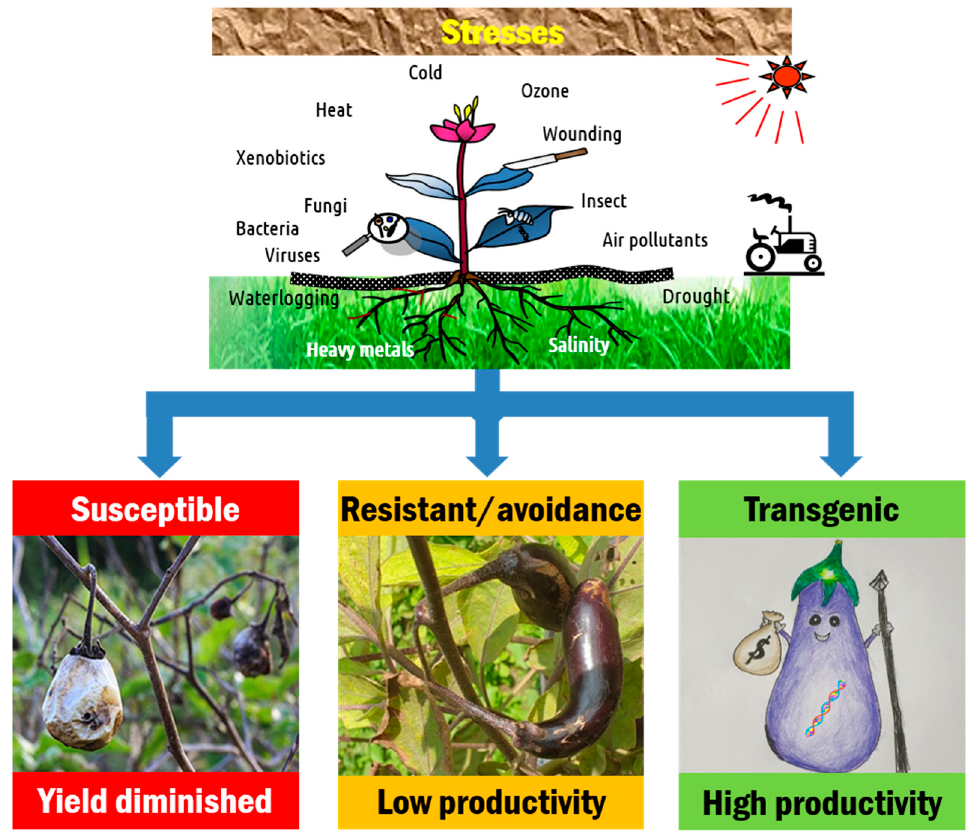
Figure 1. Stress, response, and production potential of crops. Most high-yielding cultivars are poorly adapted to environmental extremes, while landraces are able to tolerate or avoid stresses and are low-yielding. Due to poor recombination of these desirable traits through conventional hybridization, direct introduction of a single or several genes (transgenic) to modern cultivars conferring stress tolerance would be a feasible solution to sustain yield under changing agricultural